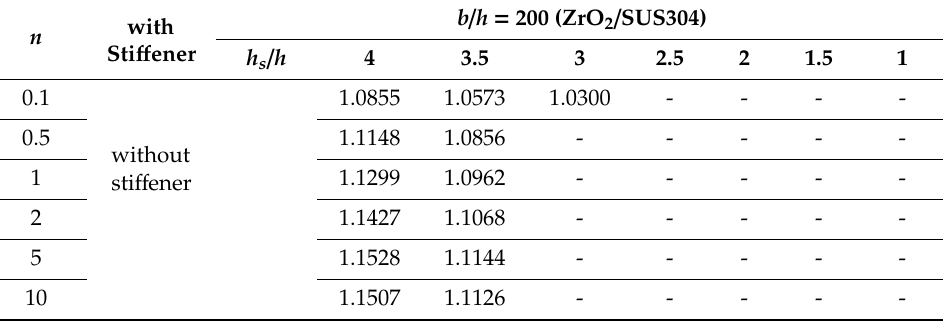
Table16. ThemassreductionbetweenZrO 2 / SUS304platewithandwithoutacentralsti ff ener( b / h =